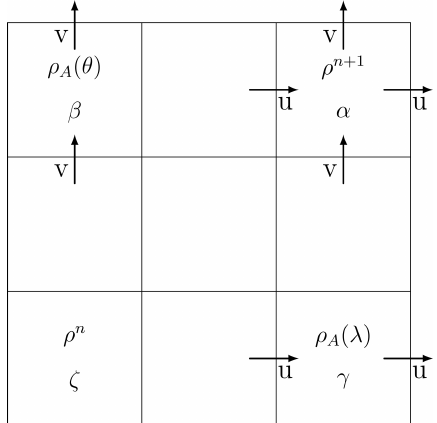
Figure 1. Schematic illustration of the dimensionally split scheme. ρ n , ρ n + 1 , ρ A (λ) , and ρ A (θ) are tracer mixing ratios corresponding to Eqs. (6), (7), and (8); the Greek letters α , β , γ , and ζ represent the individual cells.